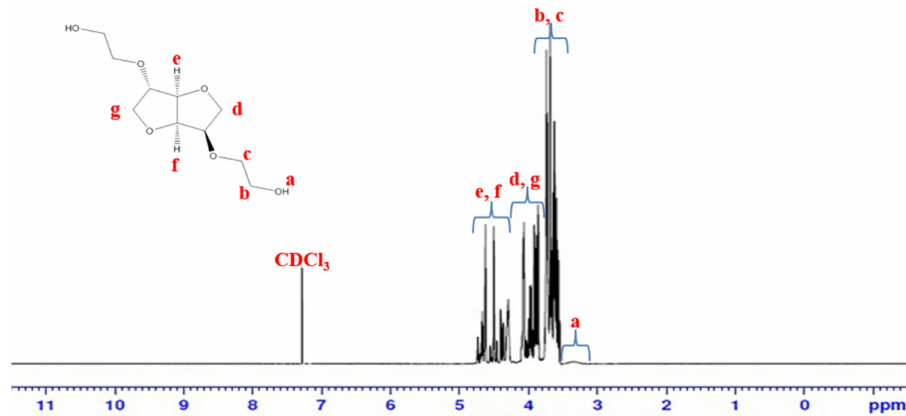
Figure 2. GC-Mass analysis of synthesized BHIS.